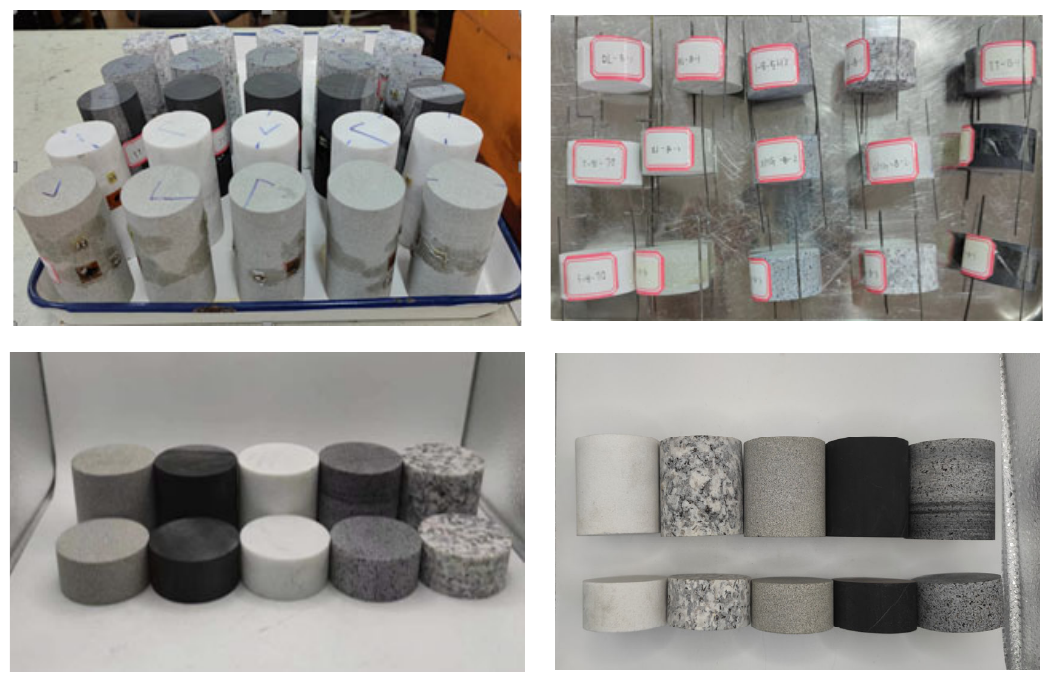
Figure 1. Five types of rock specimens.